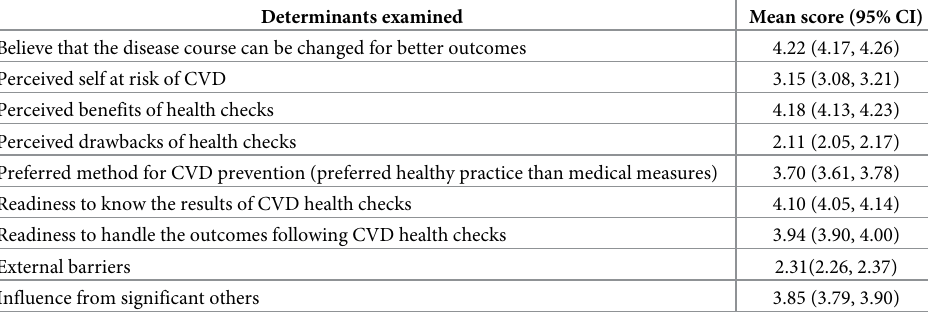
Table 2. The mean scores and 95% confidence intervals for degree of agreement for